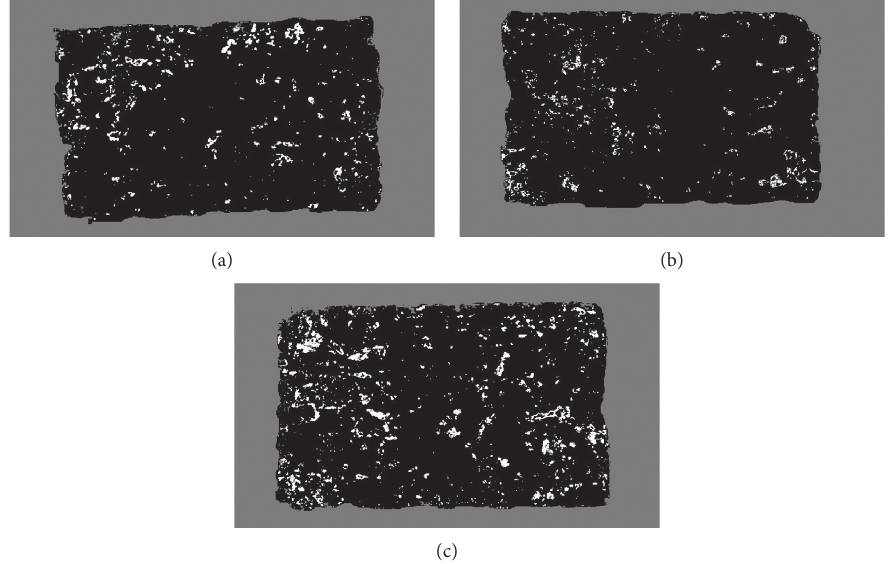
Figure 18: Thresholding applied on clustered samples. (a) Dry-HP180, (b) 1FT-HO180, (c)